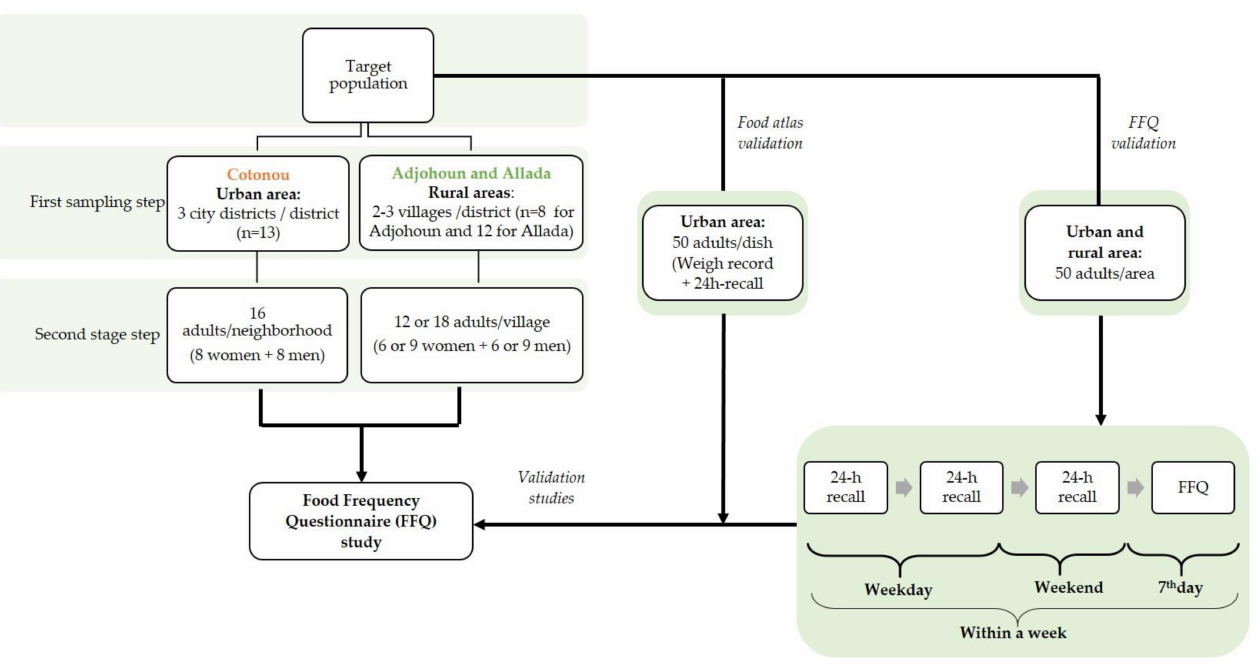
Figure 2. Schematic representation of the survey